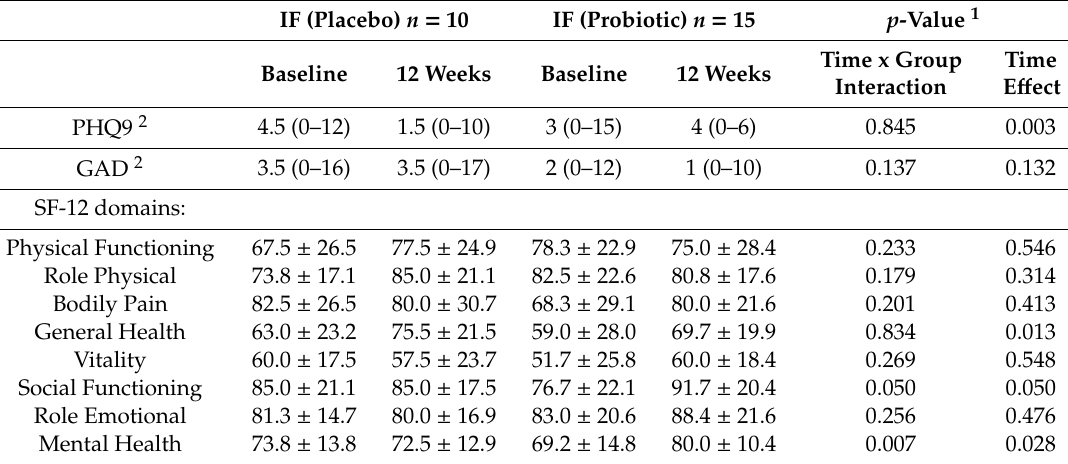
Table 4. Results of depression scores measured by the Patient Health Questionnaire 9 (PHQ9) questionnaire, anxiety scores measured by the General Anxiety Disorder (GAD) questionnaire and quality of life scores measured by the Short Form 12 (SF-12) questionnaire at baseline and 12 weeks in the IF placebo and IF probiotic